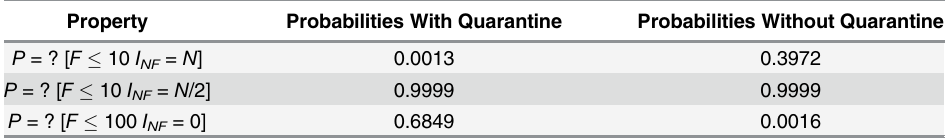
Table 3. Results with and without Quarantine for sample size 26.